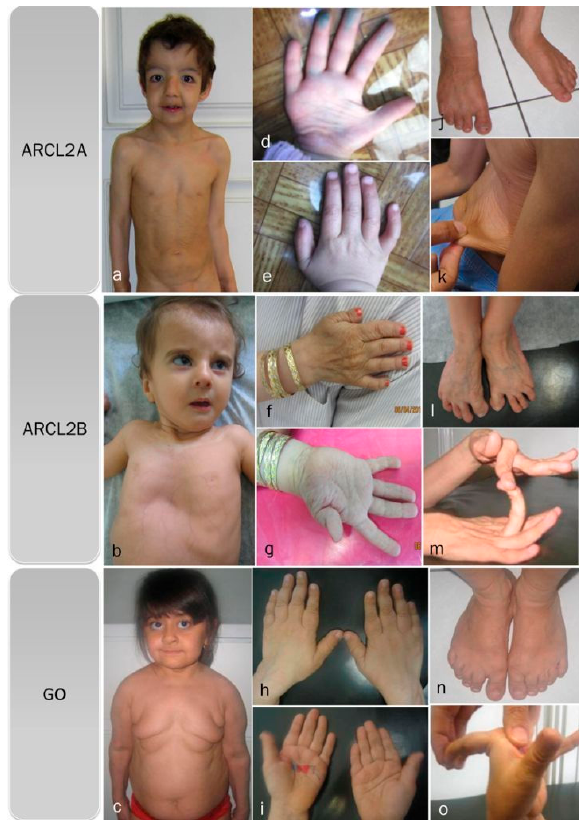
Figure 1. Overlapping clinical features of ARCL2A, ARCL2B, and GO cases. ( a ) Frontal view of patients with cutis laxa IIA, case 1; ( b ) frontal view of patient with ARCL2B case 6, note pectus excavatum, translucent skin, and visible veins; ( c ) frontal view of patient with GO case 7, note sagging and overfolding of skin; ( d , e ) note wrinkling of skin in the dorsum of hands and increased palmar creases in case 1; ( f , g ) adducted thumb seen in case 6; ( h , i ) wrinkling of skin and increased palmar creases in case 7; ( j ) flat feet in ARCL2A case 1; ( k ) cutis laxa in ARCL2A in case 2; ( l ) flat feet and increased wrinkling in dorsum of feet in ARCL2B patient case 3; ( m ) hyperlaxity of joints in ARCL2B patient case 3; ( n ) flat feet in GO case 7; and ( o ) hyperlaxity of joints in GO in case 7.